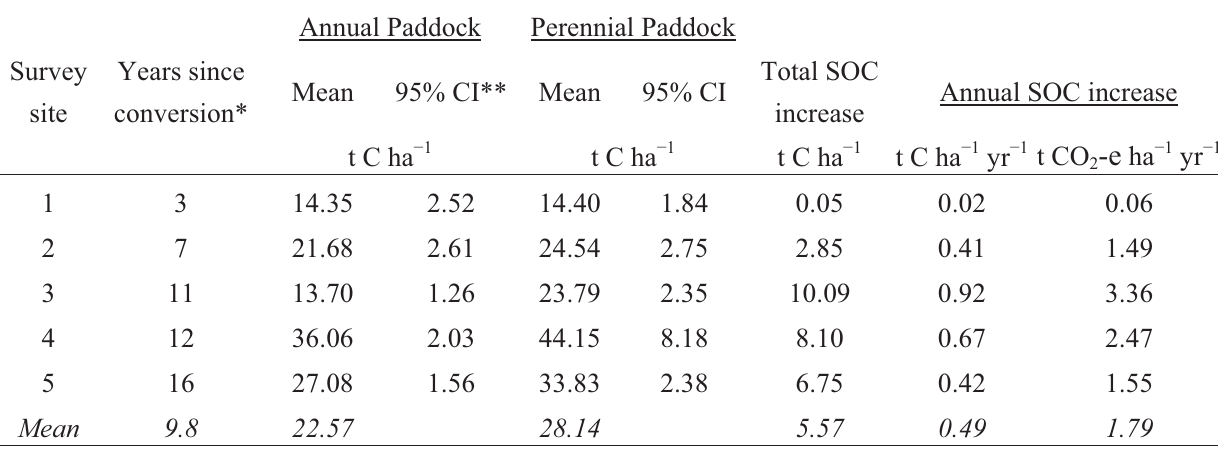
Table 2. Soil organic carbon (SOC) in annual and perennial-based pasture paddocks at five survey sites in the south-west of Western Australia (taken from [18]).